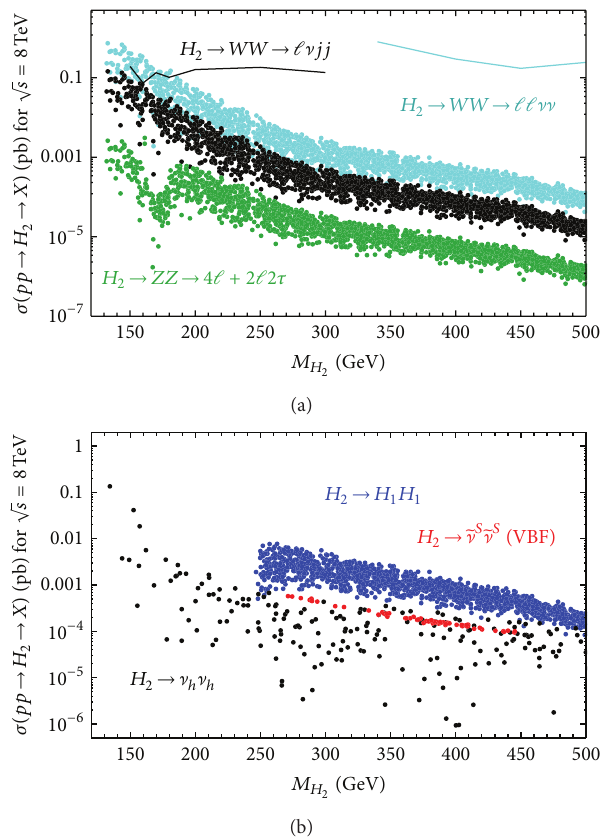
Figure 5: Cross sections at √𝑠 = 8TeV for (a) the SM-like channels and (b) the new channels, as a function of the heavy Higgs mass. The solid lines above are the exclusion curves from [20,